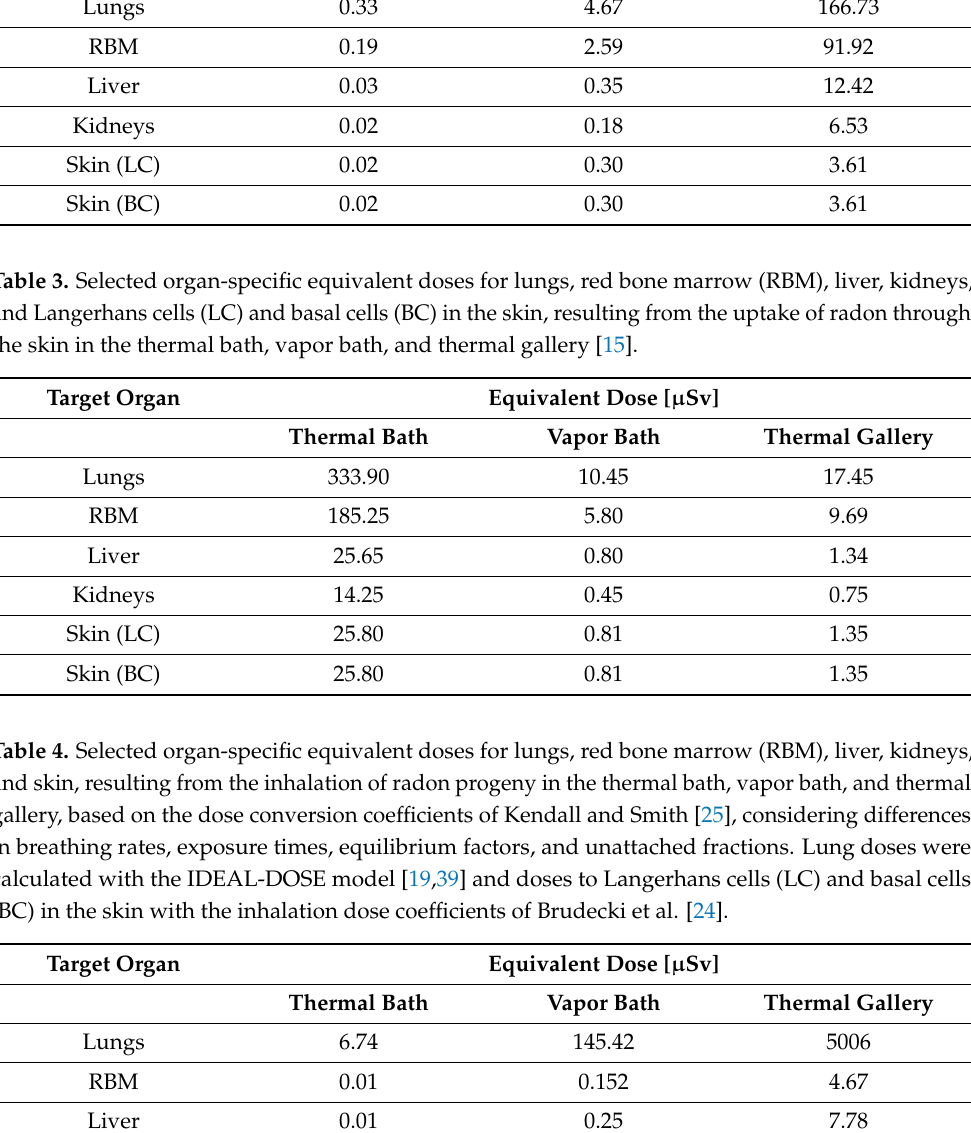
Table 2. Selected organ-specific equivalent doses for lungs, red bone marrow (RBM), liver, and kidneys, resulting from the inhalation of radon in the thermal bath (250 Bq m − 3 ), vapor bath (3.5 kBq m − 3 ), and thermal gallery 50 kBq m − 3 ), based on the dose conversion coefficients of Khur- sheed [11] and considering differences in breathing rates and exposure times. Doses to Langerhans cells (LC) and basal cells (BC) in the skin were calculated with the radon activity concentrations provided by Sakoda et al. [12]. Target Organ Equivalent Dose [ µ Sv] Thermal Bath Vapor Bath Thermal Gallery Lungs